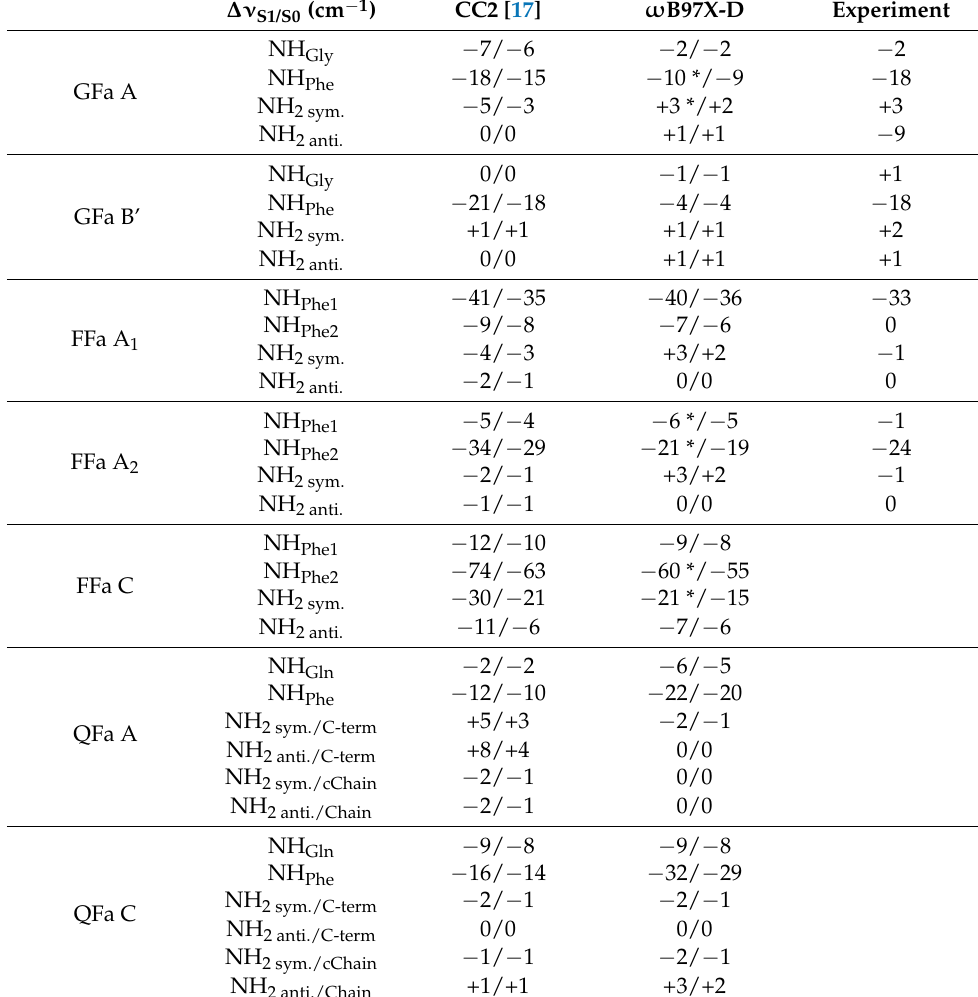
Table 6. Theoretical shifts (harmonic x and mode-dependent corrected y, i.e., x or x/y) of the amide A region harmonic frequencies of the lowest ππ * excited state optimized geometry (S 1 ) relative to the ground state optimized geometry (S 0 ) for the GFa A and B’, FFa A 1 , A 2 , and C and QFa A, C conformers obtained at the CC2/ and ω B97X-D(x)/cc-pVDZ levels, together with the corresponding available experimental data (cm − 1